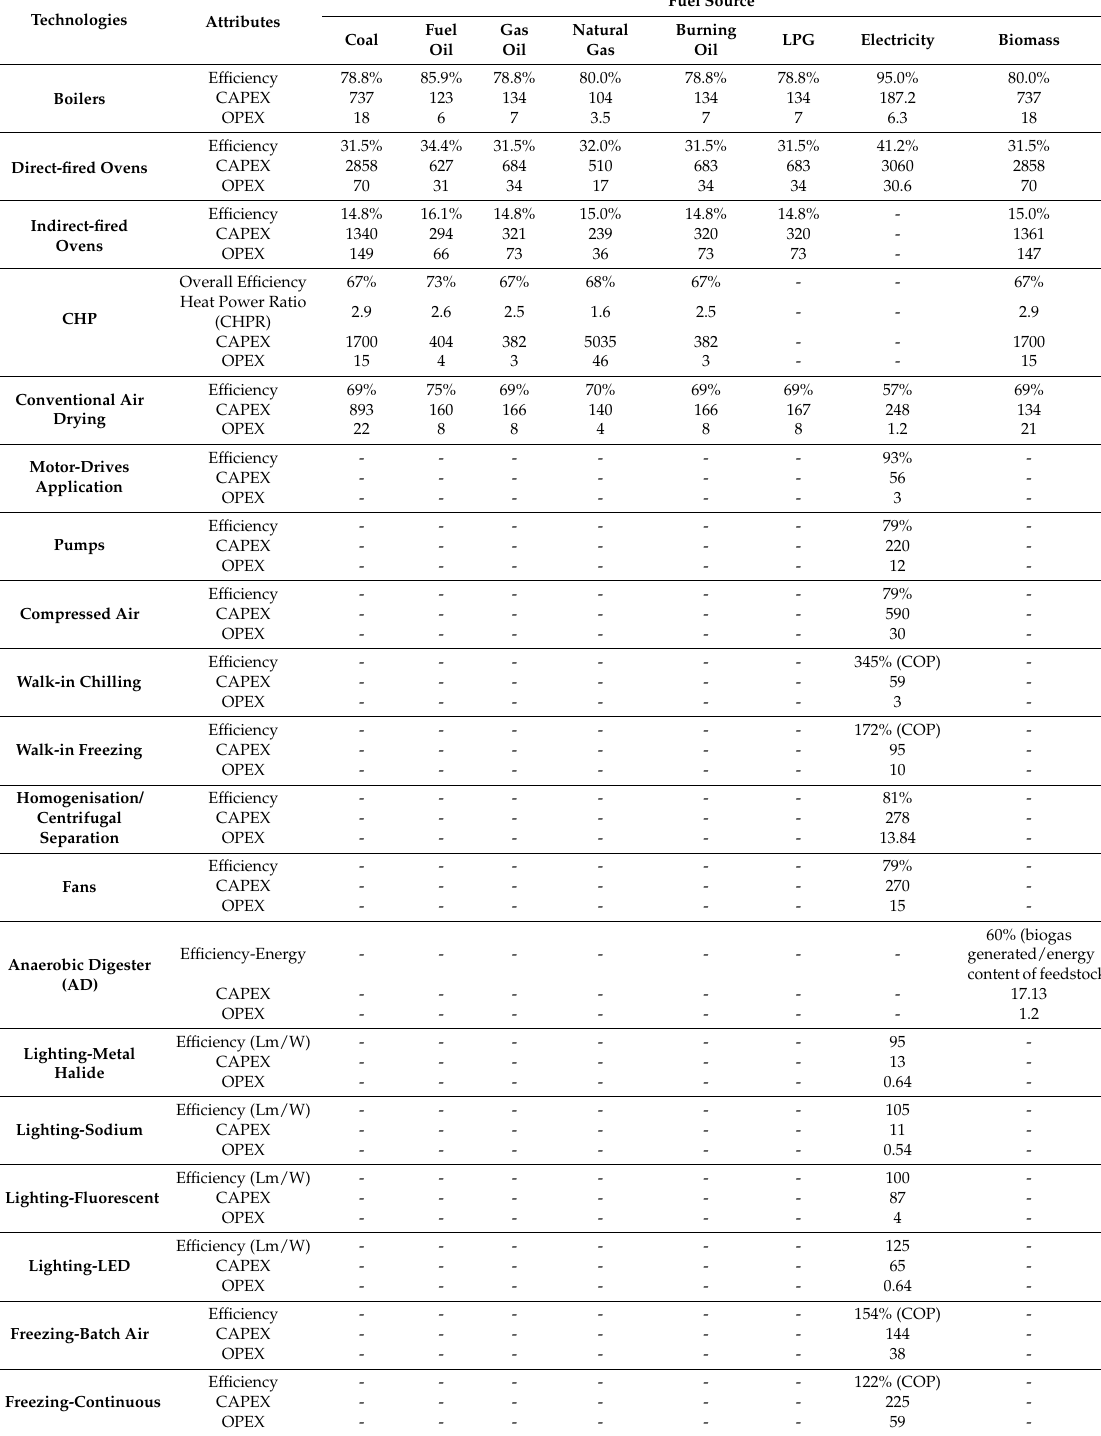
Table 2. List of Food Manufacturing technologies